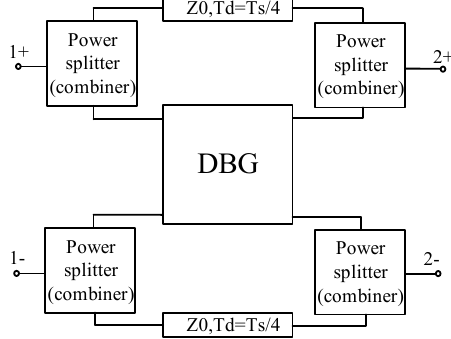
ff erential transmission isolator Figure 3. Schematic of the differential transmission isolator (DTI). Figure 3. Schematic of the di